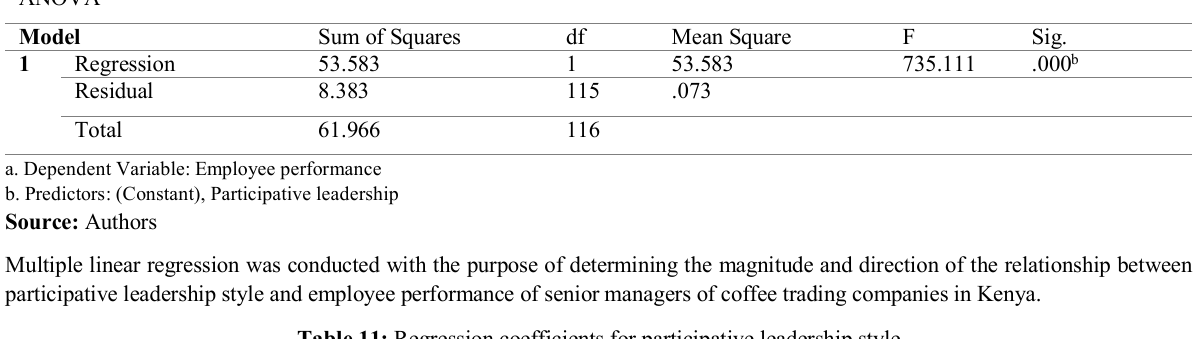
Table 11: Regression coefficients for participative leadership style